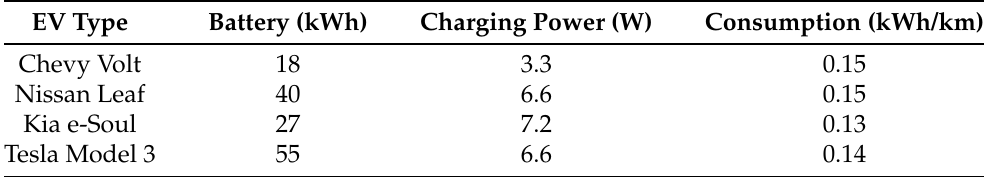
Table 2. Specification of EV